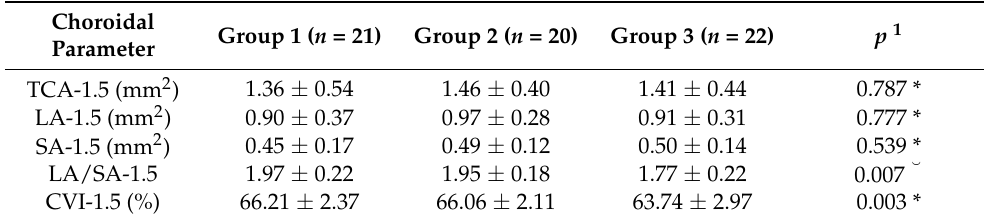
Table 4. Choroidal parameters in the studied groups for the choroidal area under the 1.5 mm horizontal line centered on the fovea.